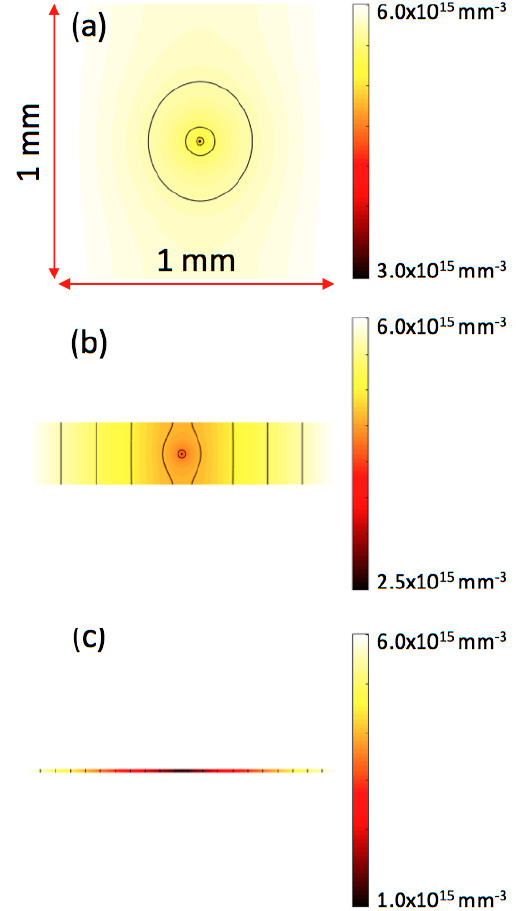
Figure 5. 2D Finite Element simulation of steady state concentration profile as a function of increasing confinement for ( a ) 1 mm, ( b ) 10 µm and ( c ) 1 µm spacing. Yellow indicates high, red/purple low concentrations. Lines indicate iso-concentration contours.